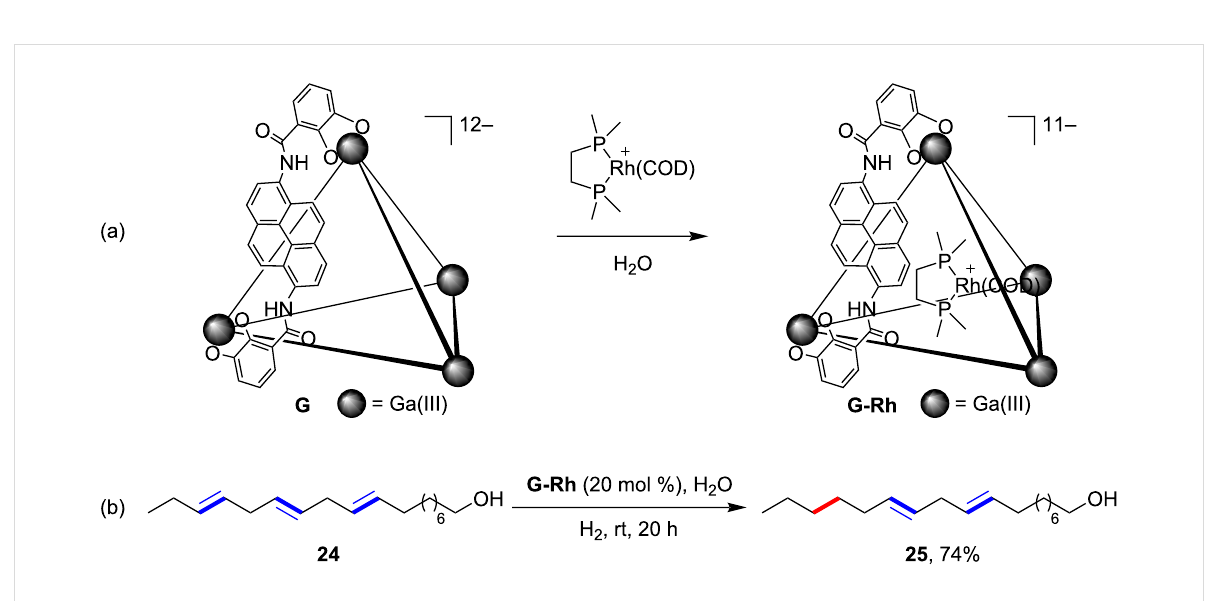
Figure 7: Site-selective hydrogenation of polyenols mediated by supramolecular encapsulated rhodium